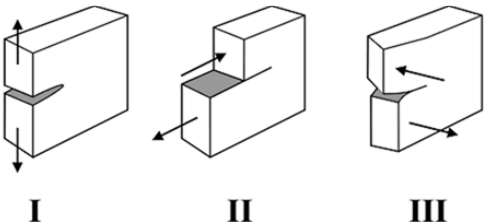
Figure 10. Characterization of three distinct fracture methods: mode I is an in-plane opening; mode II is an in-plane shear; and mode III is an out-of-plane shear loading.